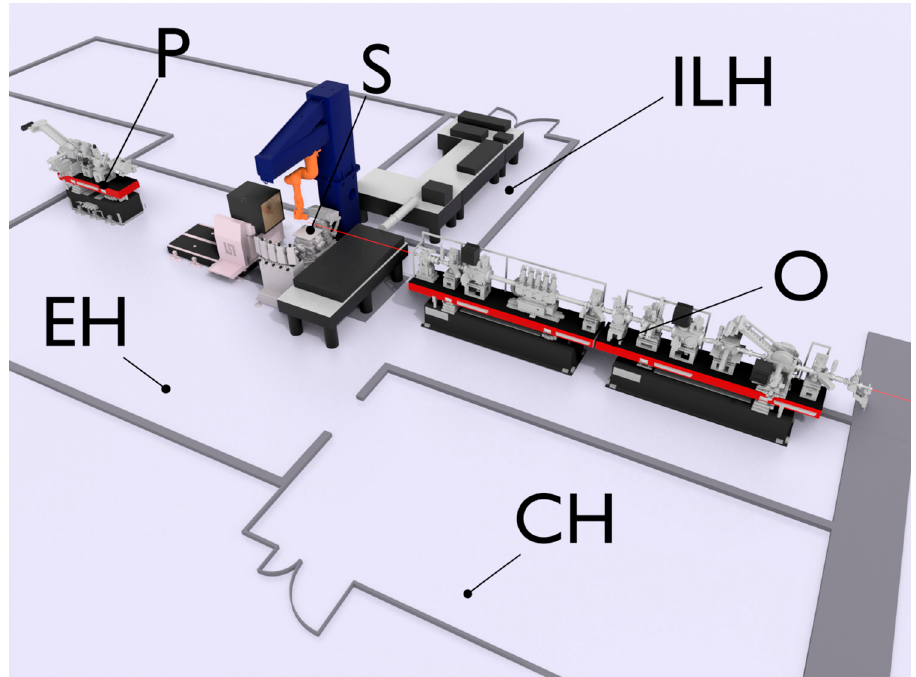
Figure 2. Layout of the scientific instrument FXE in the experimental hall of European XFEL. The SASE X-ray beam enters the experimental hutch from the right and first passes the optics and diagnostics branch (O) inside the experimental hutch (EH) [34]. The beam is focused in the sample interaction region (S) and can optionally be transported through the LPD central hole to the post-diagnostics table (P) hosting beam imaging, spectral diagnostics and intensity-position monitor units. The optical laser radiation, the excitation source for the pump-probe experiments, is conditioned and characterized in a separate instrument laser hutch (ILH), the entire experiment is remotely conducted from the control hutch (CH).